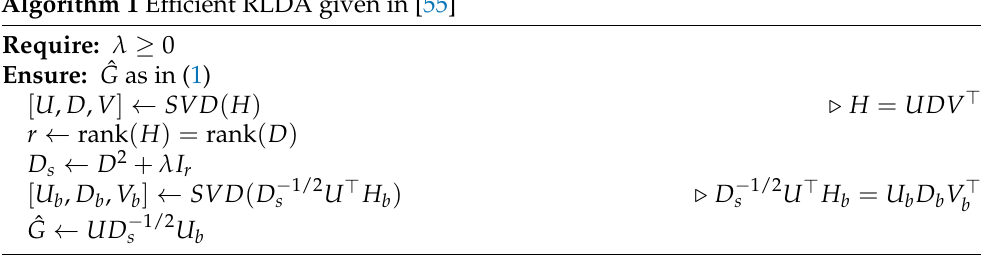
Algorithm 1 Efficient RLDA given in